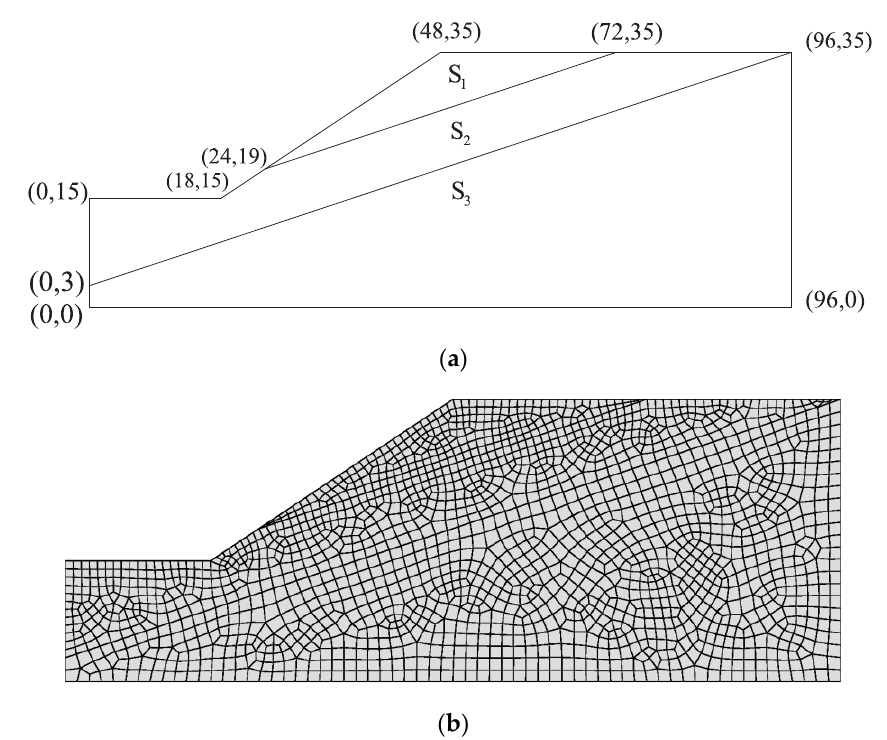
Figure 8. Geometry and adopted mesh. ( a ) geometry; ( b ) adopted mesh. Table 2. Mechanical Parameters of Section 5.2.